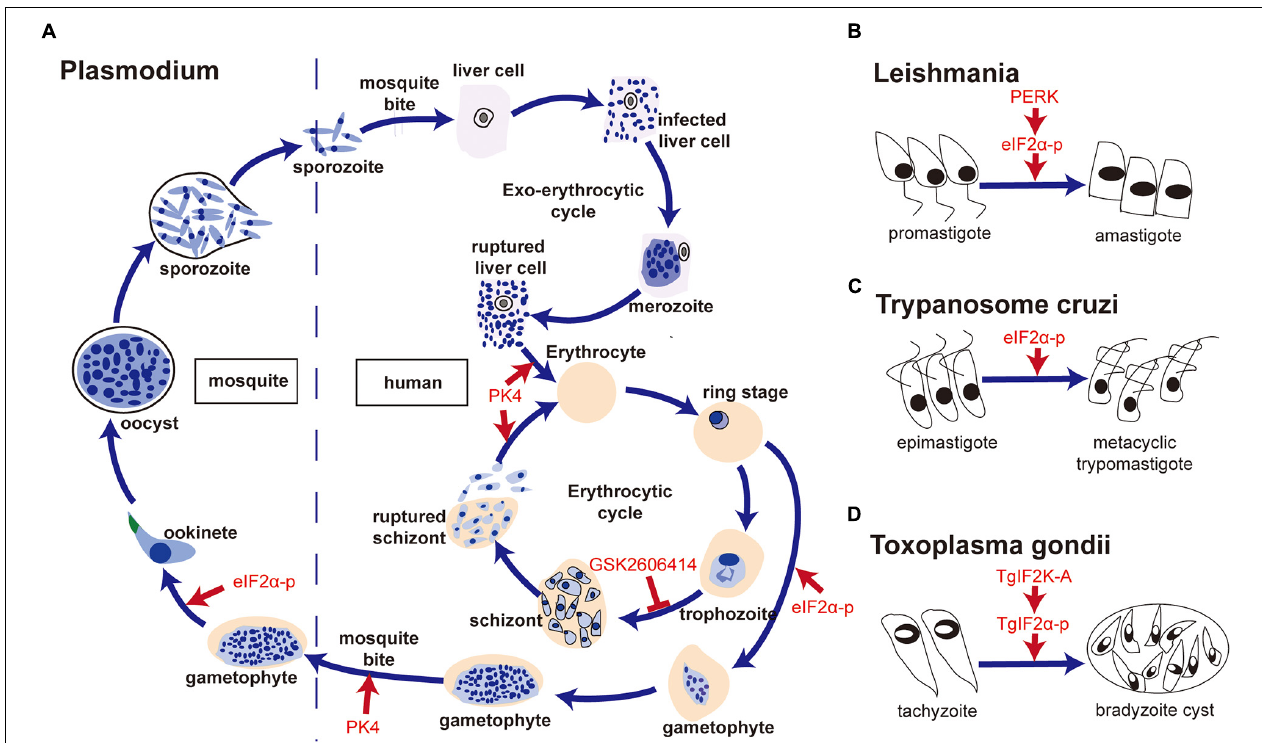
FIGURE 3 | The PERK-eIF2 α pathway is involved in forms transformation of parasites. (A) PK4-eIF2 α was associated with the formation of gametophytes, conversion of Plasmodium gametophytes into ookinetes, invasion of new red blood cells by merozoite-containing schizonts and the infection of Anopheles mosquitoes by gametocytes; (B) PERK- eIF2 α phosphorylation was vital for the switch from promastigote to amastigote in Leishmania ; (C) Tc-eIF2 α phosphorylation was required for the differentiation of non-infective epimastigotes into infective metacyclic trypomastigotes of T. cruzi ; (D) TgIF2K-A/TgIF2 α phosphorylation was related to bradyzoite cyst differentiation in T. gondii